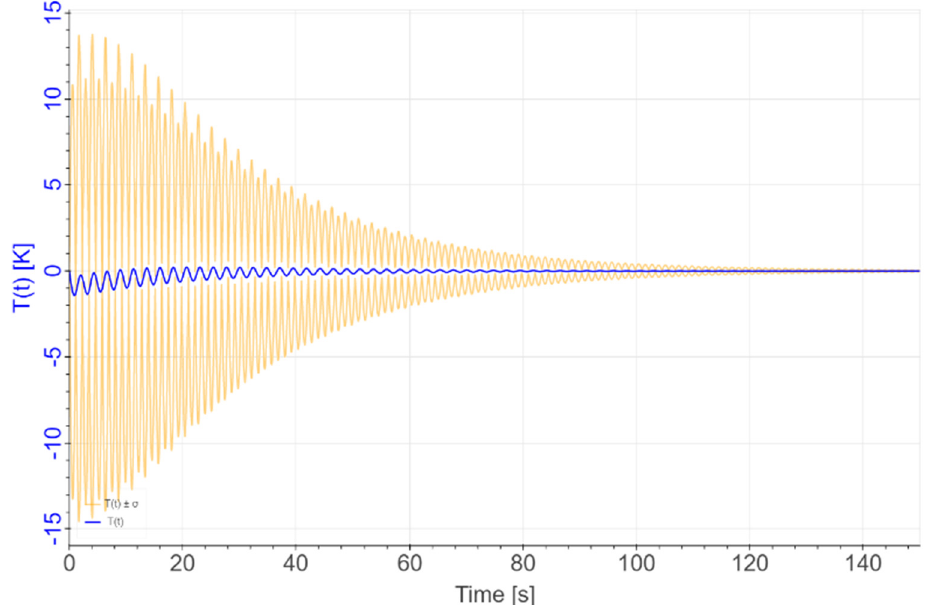
Figure 5. Time evolution of T ( t ) (blue graph) with uncertainty bands T ( t ) ± σ (yellow graphs), considering uniform 5% relative standard deviations for all parameters and 5% absolute standard deviations for the initial conditions in Region 1.